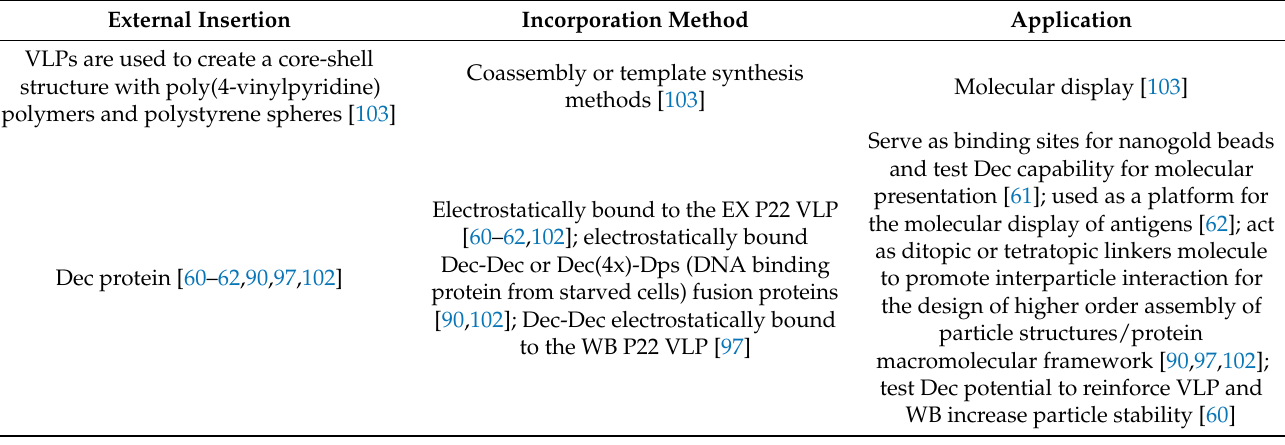
Table 2. Different types of the functionalization of P22